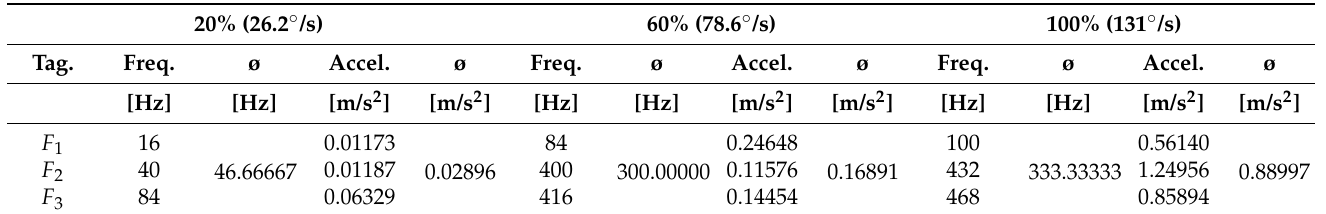
Table 6. Evaluated measured values of frequency and acceleration in X -axis for each velocity.